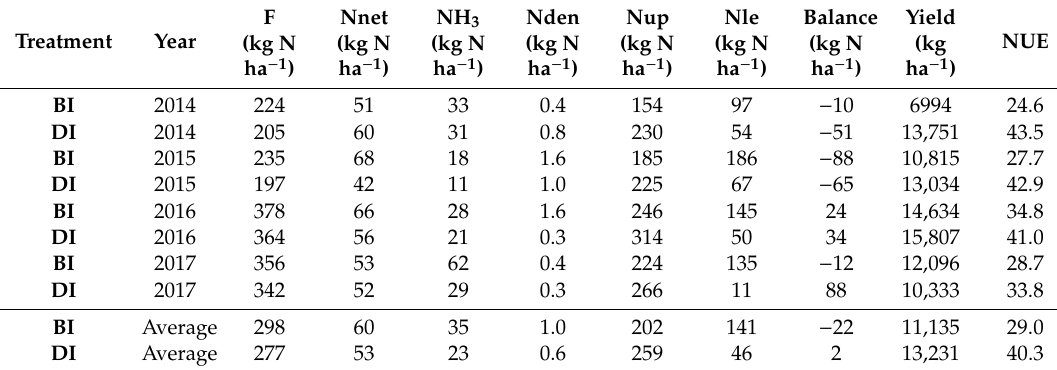
Nitrogen budgets and nitrogen-use e ffi ciencies (NUE) during 2014–2017 under the two treatments. F: N fertilizer; Nnet: net mineralization; NH 3 : ammonia volatilization; Nden: N denitrification; Nup: crop N uptake; Nle: nitrate leaching; Balance = F + Nnet- NH 3 - Nden- Nup- Nle; NUE = grain yield / (NH 3 + Nden + Nup +